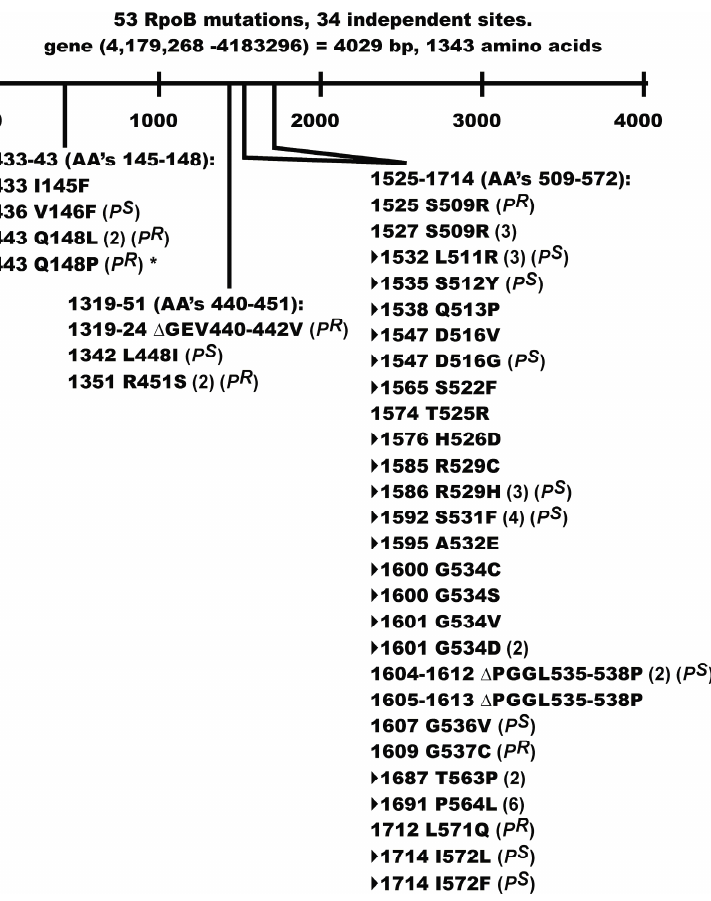
Figure 4. Location of selected Rif R mutations in rpoB . Mutants designated P S are transformable at 30 °C but not 37 °C by pcIpR ‐ P ‐ timm, whereas the P R mutants were transformable at both temperatures. The rpoB mutant designated with * is identical to mutant rpo*148 (see Discussion). The missense mutations (designated by sideways triangle) each fall within codons for amino acids found in the Rif binding pocket of rpoB .